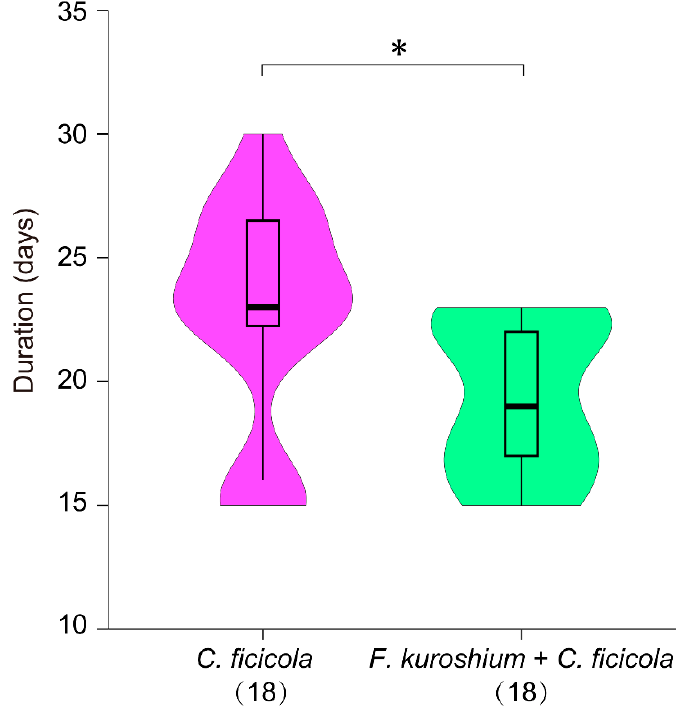
Figure 3. Violin plot representing the distribution in duration from the inoculation to death of fig saplings for T3 treatment ( Ceratocystis ficicola ) and T4 treatment ( Fusarium kuroshium + C. ficicola ) in the inoculation test. Boxes span the first to third quartiles; thick horizontal lines within the boxes show the median values; whiskers indicate values within the 1.5 interquartile range. The figure in parentheses indicates the number of saplings. *: statistically significant at p = 0.011 < 0.05 using the Mann–Whitney U test.